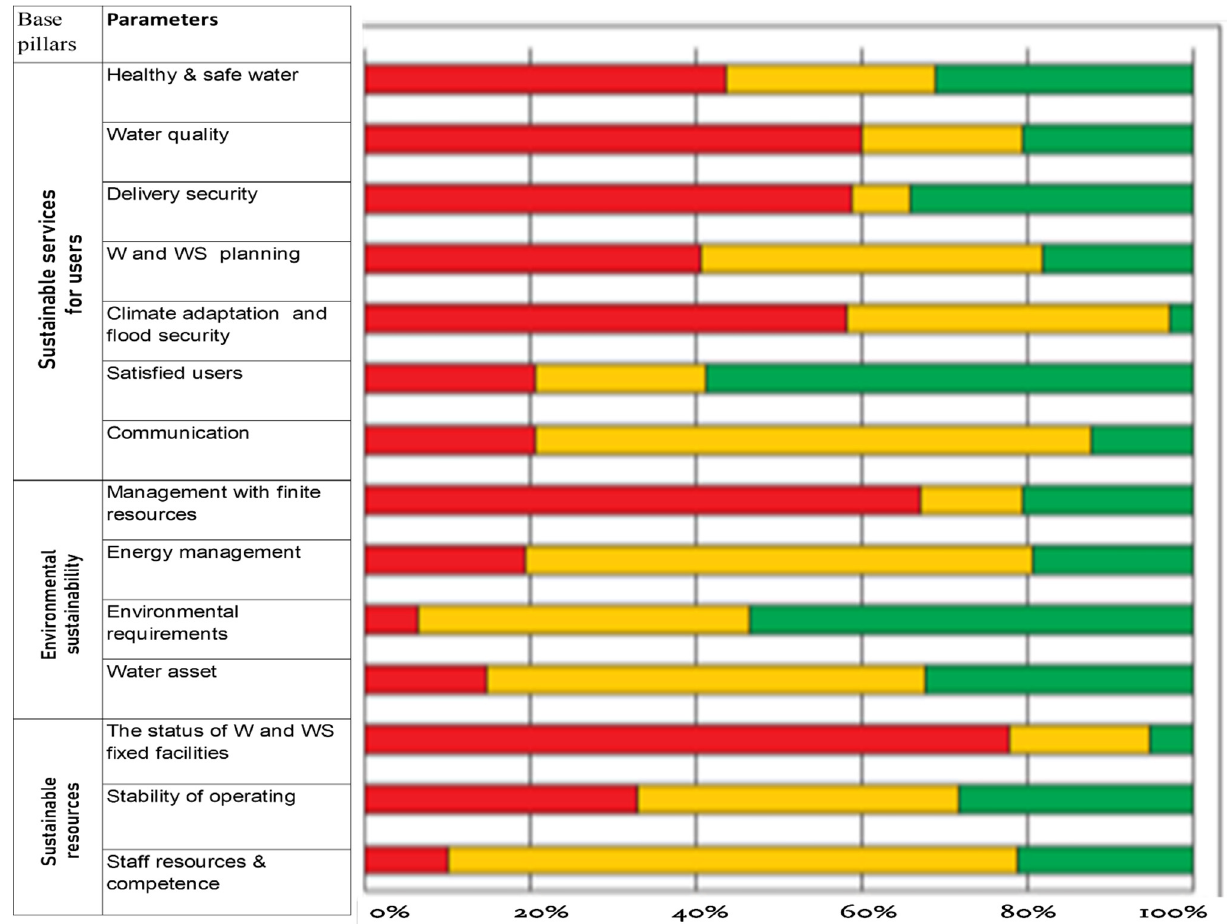
Figure 3. Parameter results for 171 participating municipalities in SI 2019 [7].